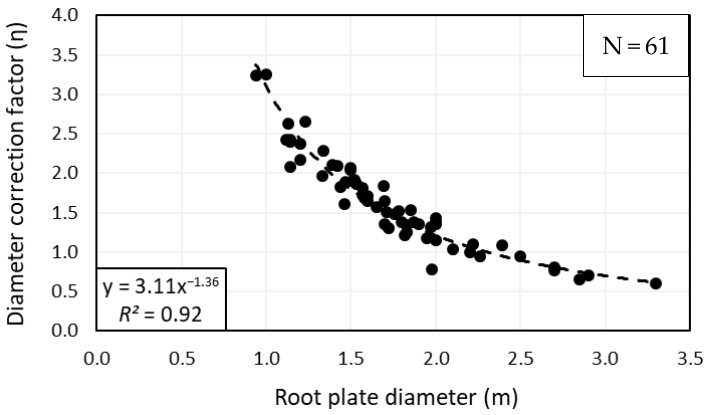
Figure 5. Diameter correction factor for hardwood trees in the damaged area.